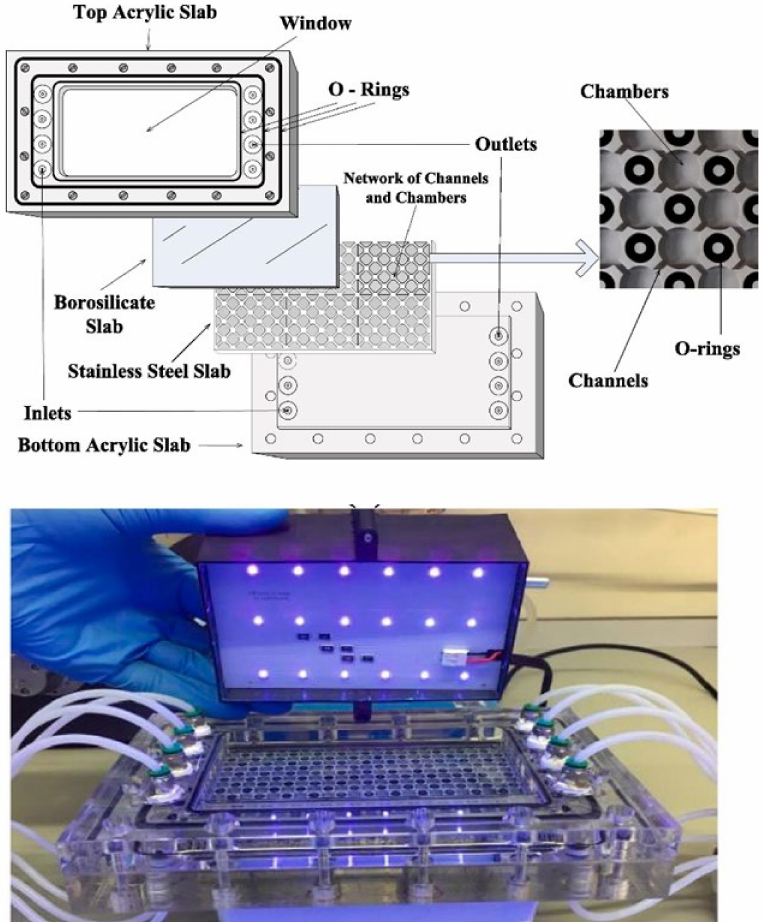
Figure 6. Schematic representation and photograph of the NETmix Microscale photoreactor with LED light for n-decane photo-oxidation in gas phase, reproduced with permission from [117], Copyright 2019,